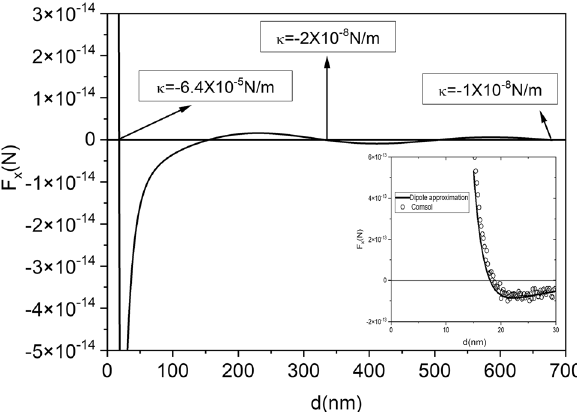
Figure 3. Force versus inter-particle distance for silver nanoparticles of r = 5 nm radius illuminated with a plane wave of intensity 25 µ W / nm 2 . The polarization angle and the wavelength considered are marked with a red star in Figs. 1 and 2. The value of the spring constant at three stable equilibrium points (one in the near field and two in the intermediate-far field region) are marked. The inset shows a comparison of the dipole approximation with the finite elements full numerical